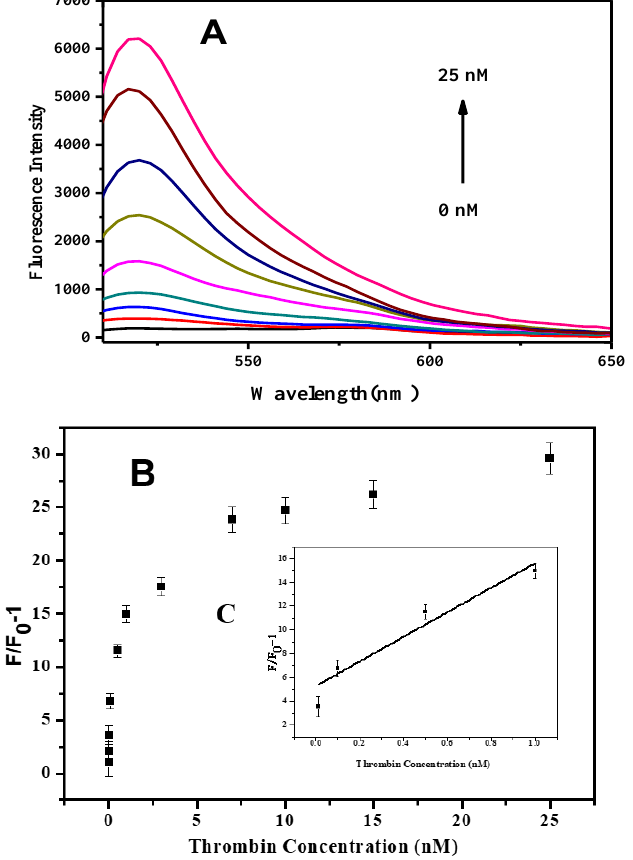
Figure 5. ( A ) The detection of different concentrations of thrombin (0.000125, 0.001, 0.01, 0.1, 0.5, 3, 7, 20, and 25 nM were seperately for color lines from bottom to top) using the GO-DNA sensor; ( B ) and the inset ( C ) the values of F/F 0 -1 for the assay with the concentrations of thrombin. The number of samples was 5.